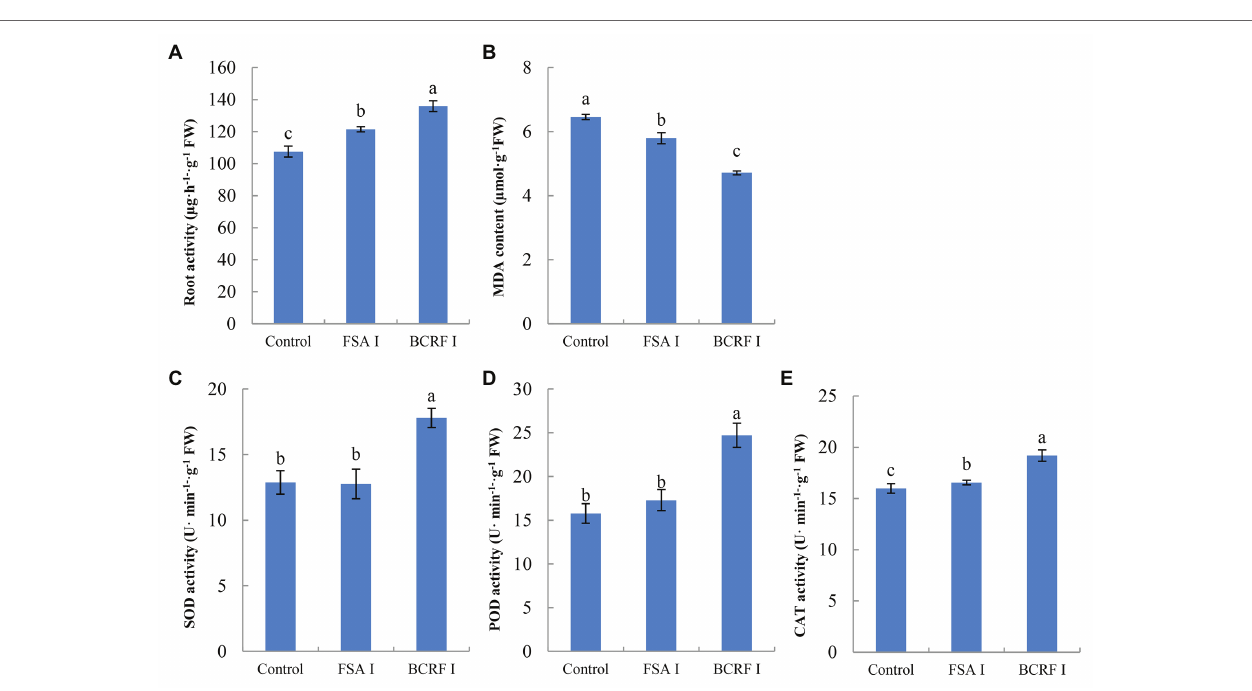
FIGURE 4 | Effects of bag-controlled release fertilizer on superoxide dismutase (SOD; A ), peroxidase (POD; B ), and catalase (CAT; C ) activities and malondialdehyde (MDA) content (D) in peach tree leaves. The vertical bars indicate the standard deviation of three replications. Different letters indicate statistically significant differences ( p <